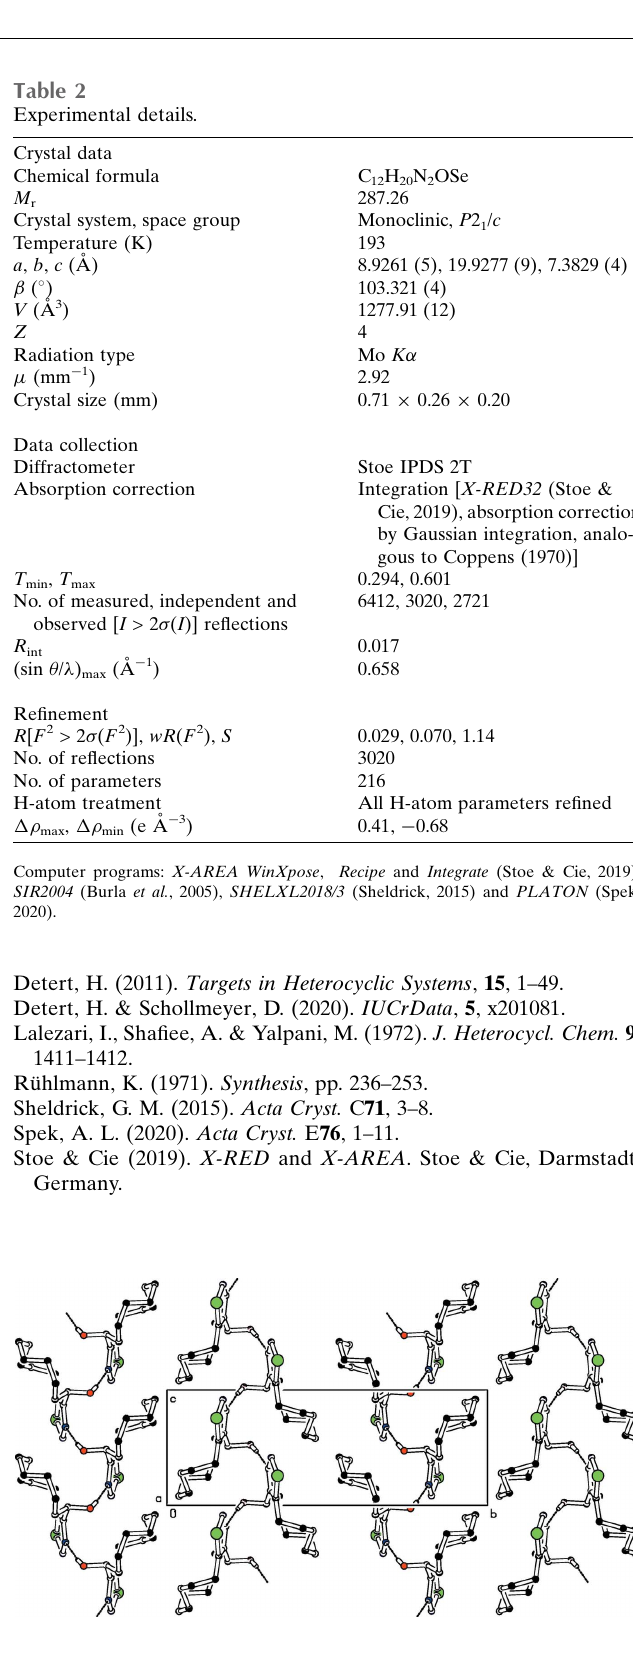
Figure 1 Perspective view of the title compound. Displacement ellipsoids are drawn at the 50% probability level.